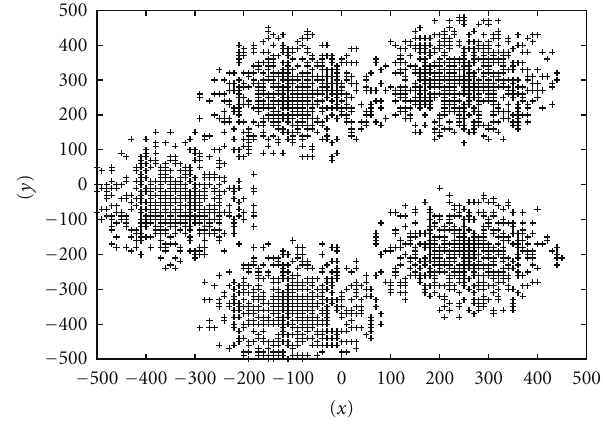
Figure 4: The numerical data. Figure 5: The inversely exponential cooling schedule of DA. The temperature decreases from T high . (Inverse of temperature β increases from 1 . 0 × 10 − 5 or 1 . 0 × 10 − 6 to 1 . 0 × 10 − 3 ) The curves are parameterized by the temperature reduction rate r